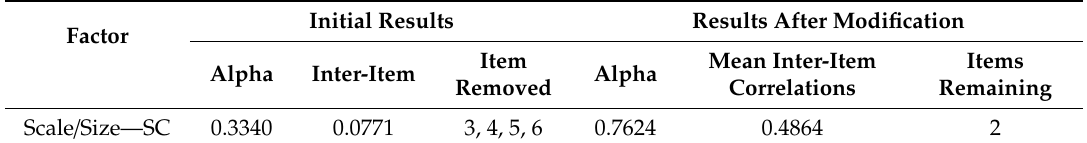
Table 4. Scale coe ffi cient of reliability for SC after modification.